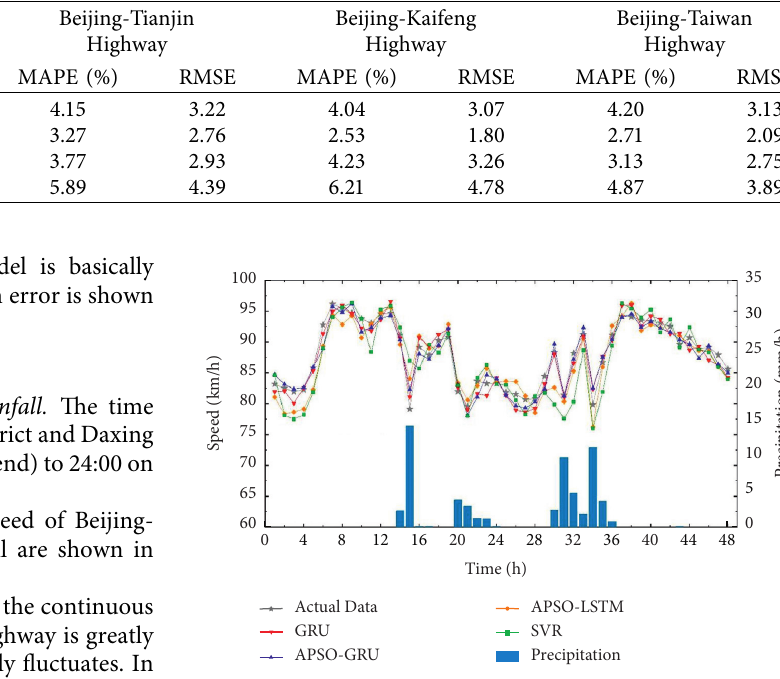
Figure 7: Prediction results of traffic flow speed during sustained rainfall on Beijing-Harbin